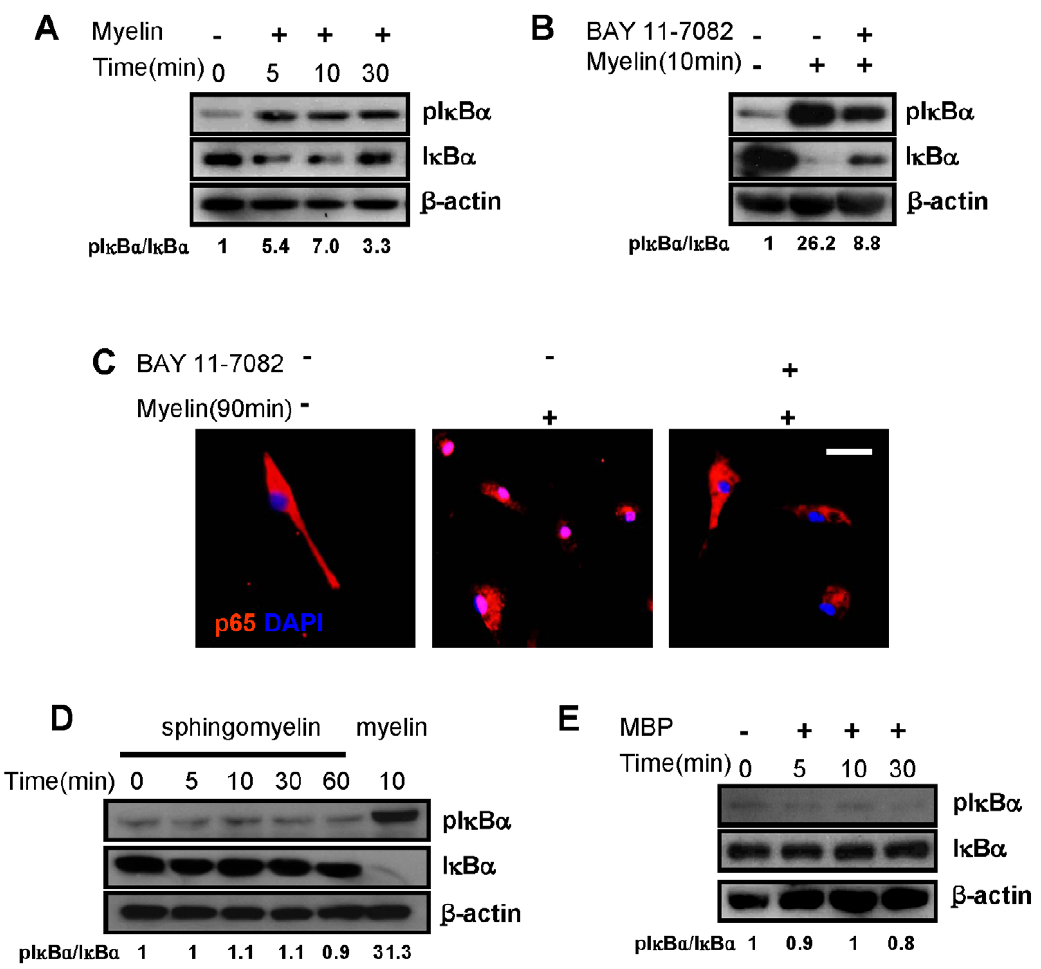
Figure 4. Effect of myelin on NF- k B activation. (A) Bone marrow-derived macrophages were incubated with myelin for indicated time and phosphorylation/degradation of I k B- a were assessed by western blot. (B) Effect of NF- k B inhibitor BAY 11-7082 on myelin-induced I k B- a phosphorylation and degradation. (C) Myelin-induced p65 translocation in macrophages detected by immunofluorescent staining. p65 was stained red and nuclei were stained with DAPI (blue) (Scale bar=10 m m). (D) Sphingomyelin (25 m g/mL) had no effect on I k B- a phosphorylation and degradation macrophages. (E) MBP (1 m g/mL) had no effect on I k B- a phosphorylation and degradation in bone marrow-derived macrophages. The inhibitor was used for 30-minute pre-incubation before myelin incubation. Phosphorylation levels were normalized to non-phosphorylated total proteins. Similar results were obtained from three independent experiments.